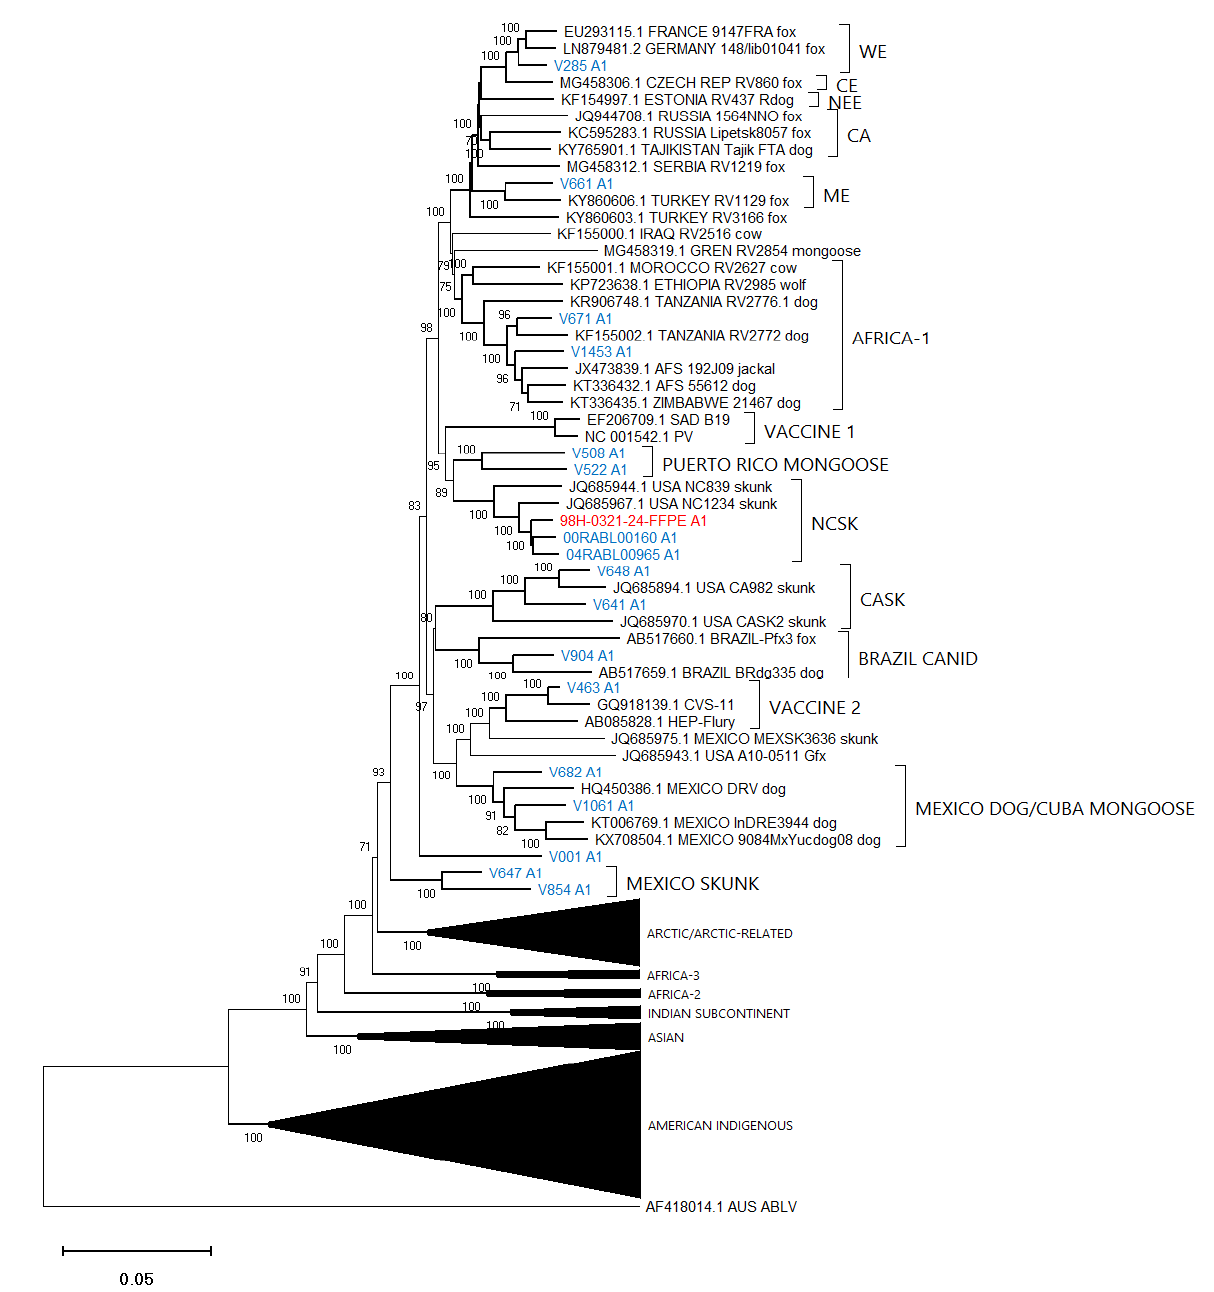
Figure 6. Neighbor joining tree of 86 RABV test samples and 100 representative RABV genomes showing details of the Cosmopolitan lineage. Sample genomes were reconstructed through reference-guided assembly of the Ampliseq reads using eight different references as indicated by the A1 to A8 suffix following the taxon name. Sequences generated from unfixed samples are shown in blue while those from FFPE samples are in red. Numbers at nodes indicate bootstrap values ≥ 70%. Lineages and variants are identified to the right of the tree.